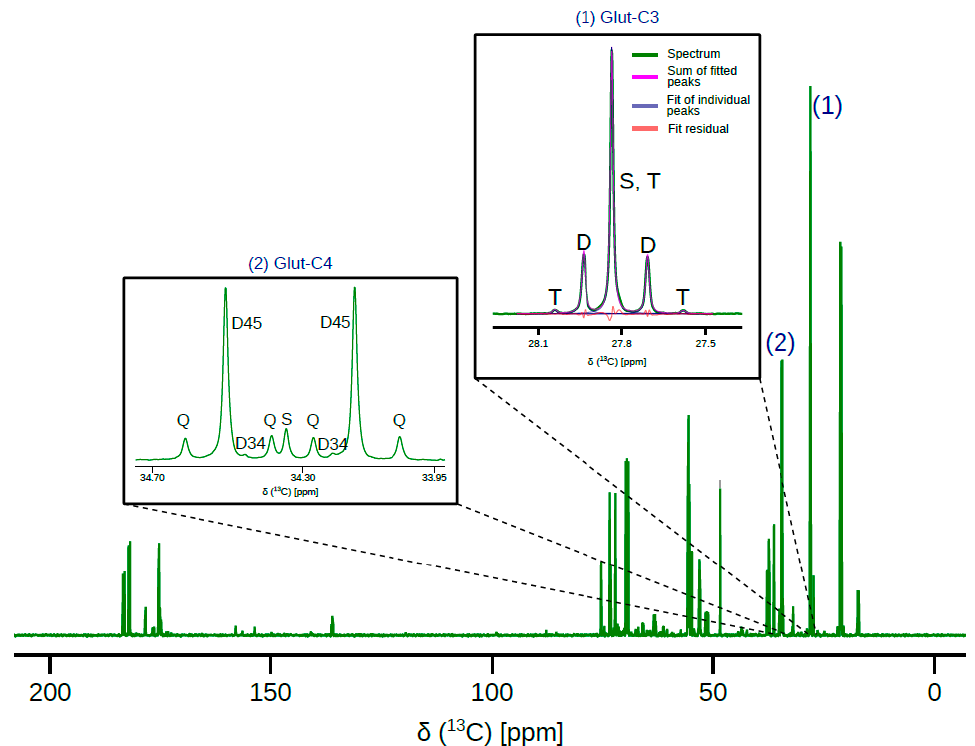
Figure 1. Representative 13 C NMR spectrum of metabolites extracted from a fetal sheep heart right ventricle. Inset (1) shows 13 C resonance of C-3 of glutamate along with line fitting carried out to estimate peak ratios. Inset (2) shows 13 C resonance corresponding to C-4 of glutamate. Line fitting is not shown in inset (2) so as to not obscure the D34 doublet. In inset (1), “T” represents triplet arising from 13 C label in carbons 2-3-4 of glutamate, “D” represents 2-3 and 3-4 isotopomers, and “S” arises 13 C label in carbon-3 of glutamate in addition to natural abundance. In inset (2), “Q” represents quartet arising from 13 C label in carbons 3-4-5 of glutamate; “D45”, doublet from 4-5 of glutamate; “D34”, doublet from 3-4 of glutamate; and “S” is singlet from 13 C label in carbon-4 of glutamate in addition to natural abundance. 13 C spectra acquisition parameters are detailed in Section 4. Circulating glucose and lactate concentrations were measured prior to and during glucose infusion using catheters present in the brachial artery and coronary sinus. As ex- pected, circulating concentration of glucose increased by about 30% with infusion of [U- 13 C]glucose, while lactate concentrations remained unchanged as shown in Figure 2a,b. Glucose and lactate consumption were, on average, 0.05 ± 0.001 mmoles/dl and 0.12 ± 0.003 mmoles/dl. Since two moles of lactate are derived from a single mole of glucose, total substrate utilized (as three carbon units) is 0.22 mmoles/dl. Of this substrate pool, ~0.034 mmoles/dl is 13 C enriched (~34% increase multiplied with 0.10 mmoles/dl (1 mM) in terms of 3-carbon units), yielding an oxidative enrichment (i.e., acetyl CoA enrichment) of 15%. This enrichment readily matches the Fc3 (fraction of acetyl-CoA enriched at both carbons of acetyl group) values obtained from 13 C spectra shown in Figure 2c.